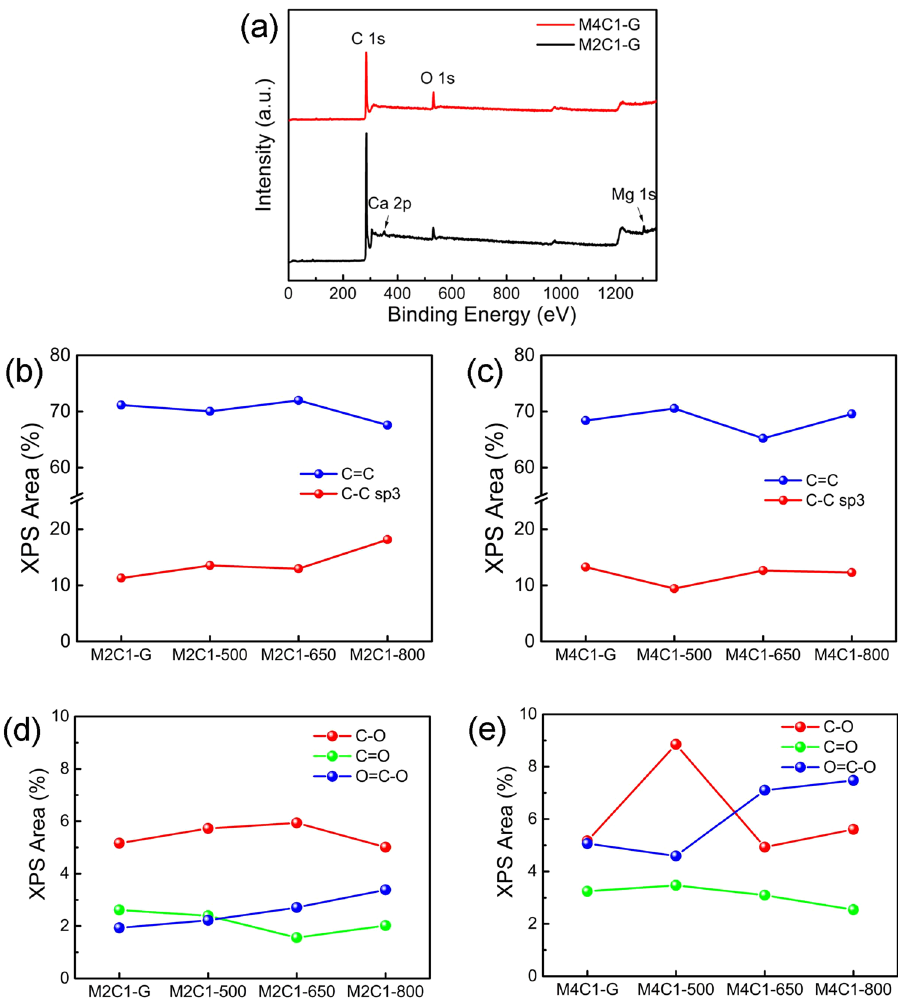
Figure 3. ( a ) XPS survey spectra of M2C1-G and M4C1-G; ( b – e) The compositions of components from C 1 s in M2C1 (( b ) and ( d )) and M4C1 (( c ) and ( e